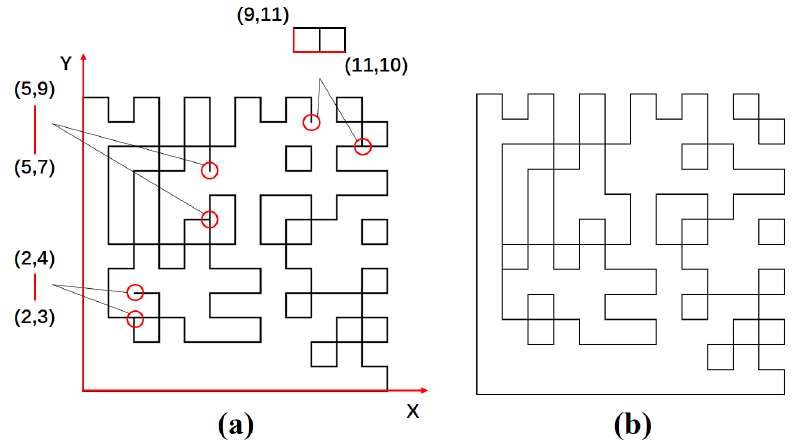
Figure 12. A final edge image forming process: ( a ) path selection in the edge image; ( b ) the corrected edge